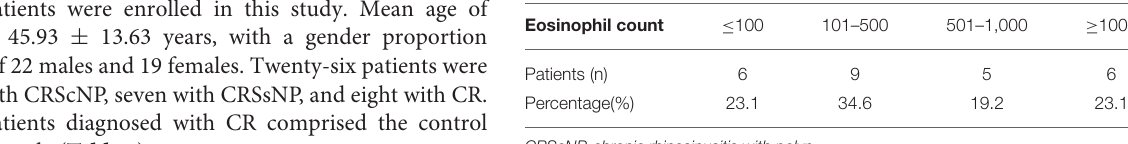
TABLE 3 | Eosinophil count distribution among CRScNP patients ( n = 26).